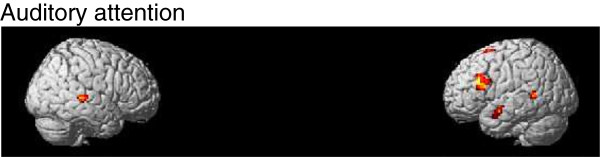
Auditory attentional effect (auditory attented relative to auditory unattended contrast, p<0.005, spatial extent=20 voxels, T=3.17).